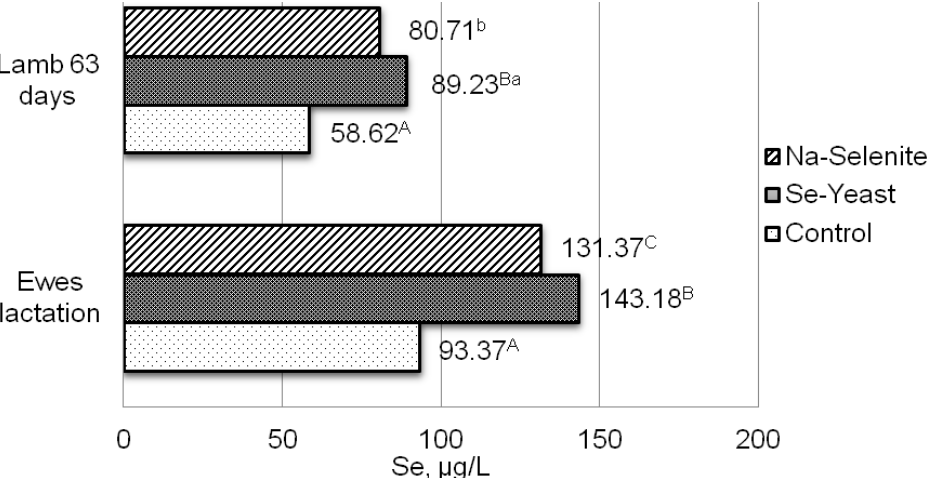
Figure 2. Concentration of selenium in whole blood of lactating ewes and 63-day-old lambs. I-control group; II-addition of organic selenium supplement; III-addition of inorganic selenium supplement; Se, selenium; a, b, p < 0.05; A, B, C, p < 0.01 differences between treatments. 3.6. Correlation and Regression Analysis between the Content of Antioxidant Parameters in the Blood of Ewes and Their Lambs According to the analysis of the correlation and regression line, there was good con- nectivity between antioxidant parameters in the whole blood of ewes, i.e., their lambs, which is indicated by the positive correlation coefficients (Tables 6–8).